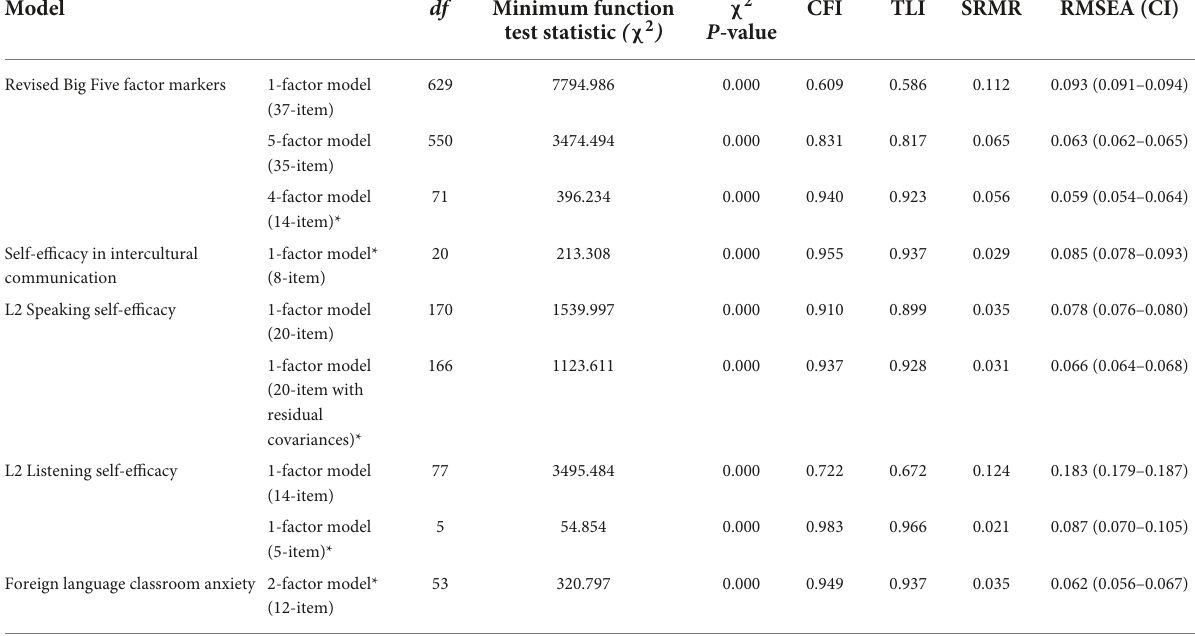
TABLE 2 Model comparison of factor structures and psychometric properties for the study instruments ( n = 1,326).